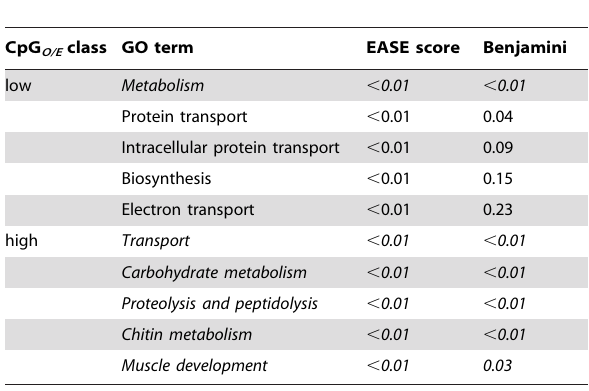
Table 2. Results of functional enrichment analysis.